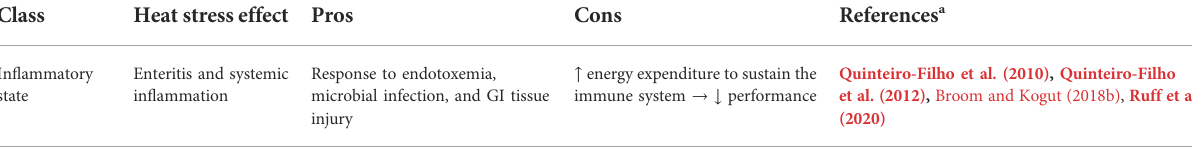
TABLE 8 Overview of heat stress effects on the in fl ammatory state of chickens.